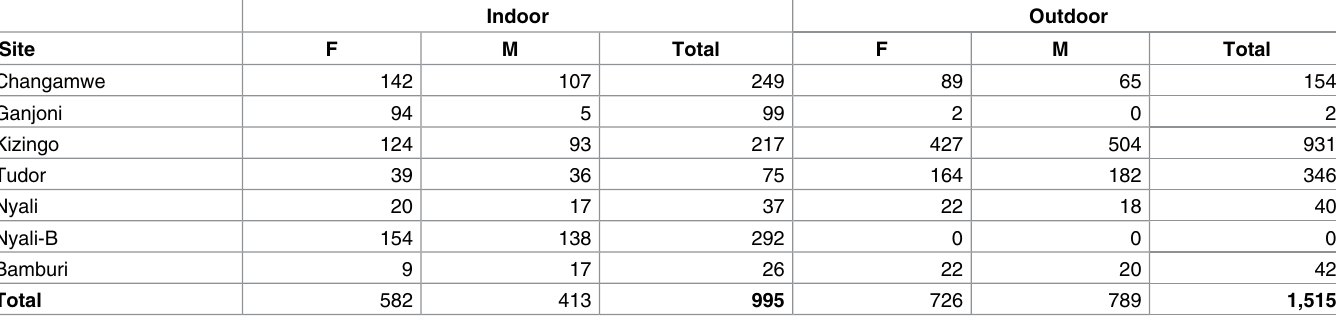
Table 5. Number of Ae . aegypti immatures collected indoors and outdoors by site. Indoor